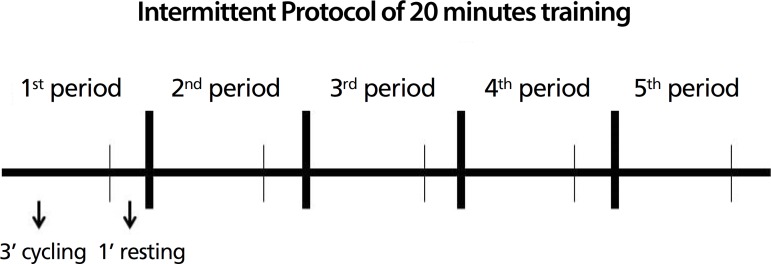
Intermittent protocol: stationary cycle ergometer exercise
training.